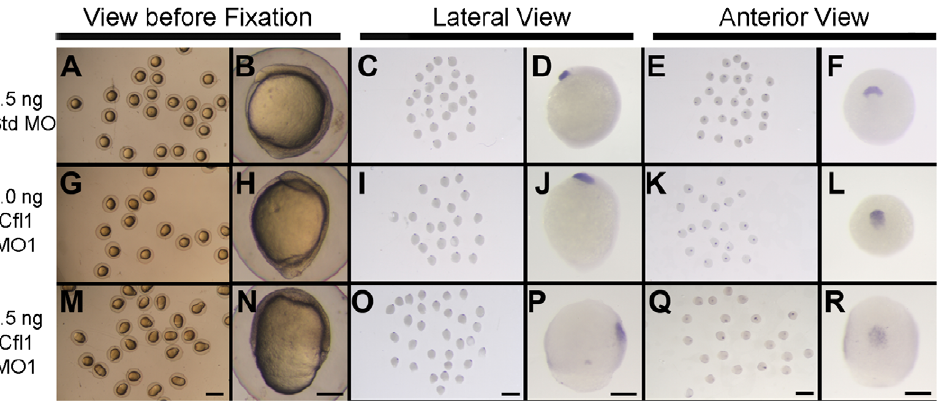
Figure 9. Knockdown of cfl1 does not affect involution of mesendoderm. Embryos injected with 7.5 ng Std MO (A–F), 5.0 ng (G–L) or 7.5 ng cfl1 tMO 1 (M–R) were examined at 10 hpf (A, B, G, H, M, N), fixed and subjected to WISH against cstl1b (C–F, I–L, O–R). Representative photographs were taken at a lower (6.3X) or higher (50X) magnification and scale bars are shown at the bottom panel of each column (1 mm for 6.3X and 200 m m for 50X).